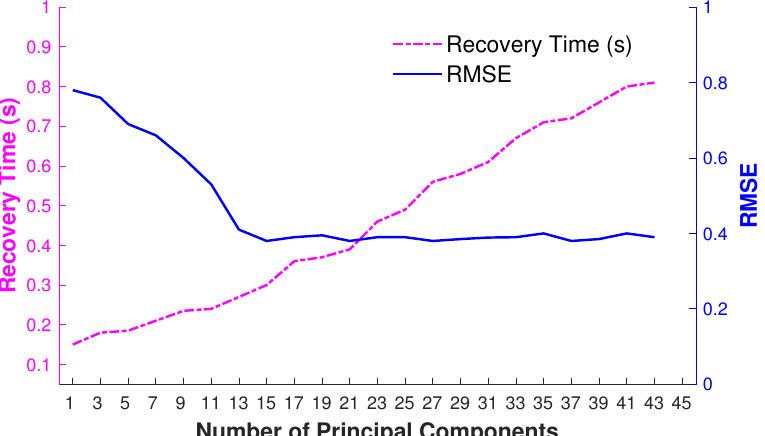
Figure 10. RMSE and the recovery time in seconds for the dynamic selection of the number of principal